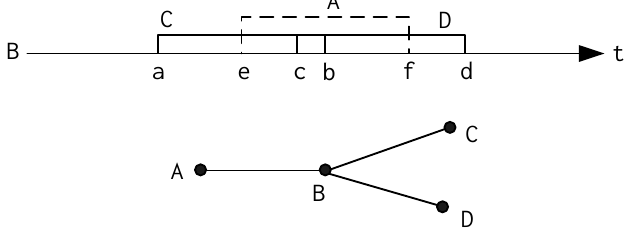
Figure 6. A node may be incapable to use the transmission time of a dead